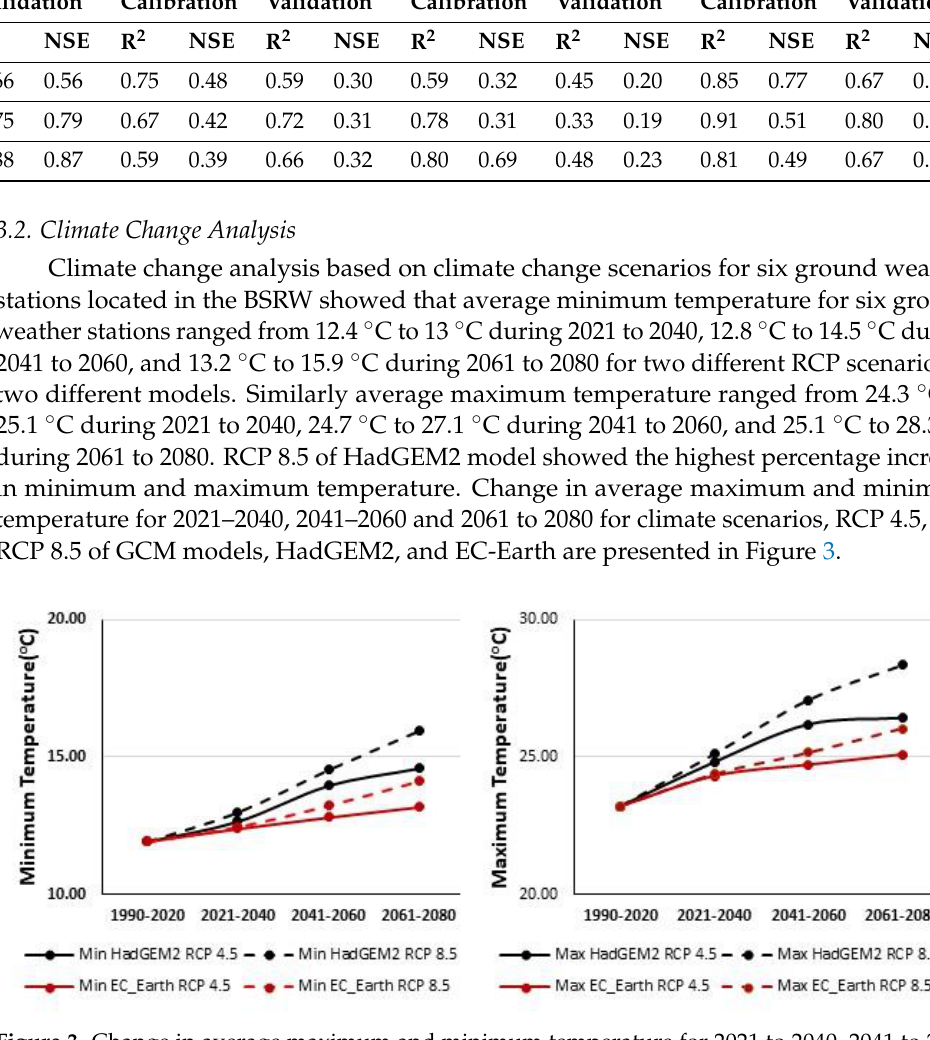
Figure 4. Change in average daily rainfall for 2021 – 2040, 2041 – 2060 and 2061 – 2080 for climate sce- narios, RCP 4.5, and RCP 8.5 of GCM models, HadGEM2, and EC-Earth is presented in Figure 2. The summary of the change in average minimum and maximum and average rain- fall for six ground weather stations during the period of 2021 to 2040, 2041 to 2060 and 2061 to 2080 for climate scenarios, RCP 4.5 and RCP 8.5 of GCM models, HadGEM2 and EC-Earth is presented in Table 2. Table 2 . Summary of change in minimum and maximum temperature and average precipitation during 2021-2040, 2041-2060 and 2061-2080 for climate scenarios: RCP 4.5 and RCP 8.5 of GCM models: HadGEM2 and EC-Earth . Parameter